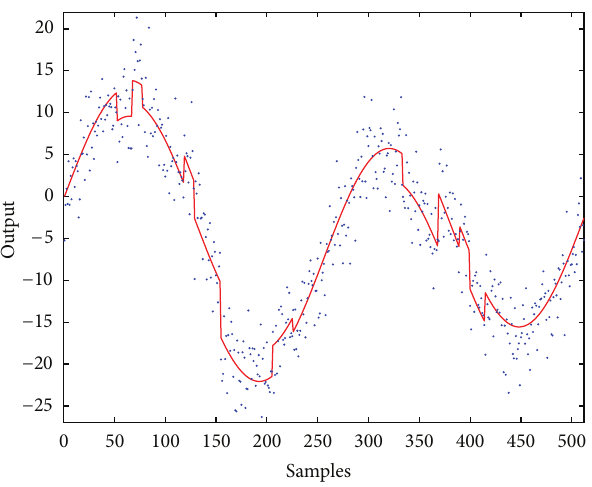
Figure 3: Sample output data set used in example 1 for the case where SNR = 10 (solid line: noise-free data; dots: noisy data).